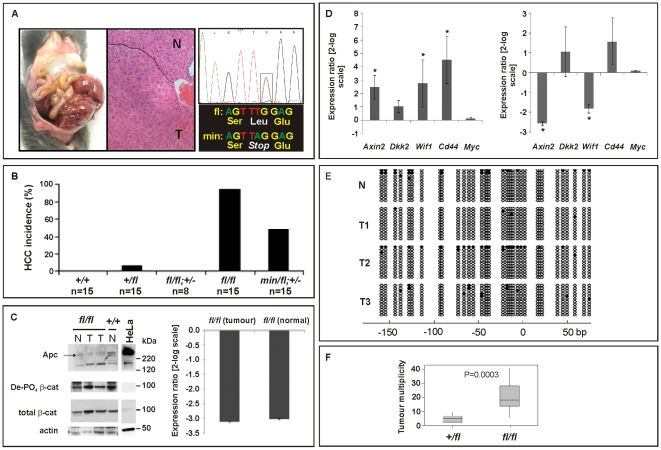
Liver phenotype in Apc mutant mice.(A) Hepatocellular carcinoma (HCC) of moribund Apcfl/fl and representative haematoxilin-eosin stained cross section with the dotted line indicating the boundary between normal (N) and tumoral (T) tissue. Representative allele-specific nucleotide sequence of DNA extracted from a liver tumor of a (min/fl; +/−) mouse demonstrating allelic balance between of the Apcmin and the floxed wt allele (boxed area). (B) Incidence of HCC in mice of the indicated genotypes. (C) Western blot and qPCR analysis of full-length Apc protein and Apc mRNA in normal (N) and tumoral (T) liver tissue of Apcfl/fl and Apc+/+ mice. Cell lysates of HeLa cells transfected with a plasmid encoding full-length wild-type Apc serves as an antibody specificity control. The abundance of de-phosphorylated, active (De-PO4) and total β-catenin protein in the same tissue extracts are shown with β-actin serving as a loading control. kDa, protein size marker in kilo Daltons. (D) Comparative qPCR analysis of representative Wnt target gene expression between normal and tumoral liver tissue collected from moribund Apcfl/fl mice (right panel). A comparable analysis was also performed on liver tissue from healthy 5mo old Apcfl/fl and wild-type mice (left panel). Mean ± SD with n≥3 mice per group. * P<0.05. (E) Bisulfite sequencing of the CpG island within the Axin2 promoter from adjacent normal (N) and tumor liver tissue (T1, T2, T3) from Apcfl/fl mice. Each vertical line refers to a CpG dinucleotide at the indicated position relative to the transcriptional start site. Following bisulfite-treatment, DNA was subcloned and sequenced. Horizontal lines represent individual sequences with open and full circles denoting unmethylated and methylated CpG residues, respectively. (F) Boxplot diagram comparing liver tumor multiplicity in +/fl mice (n = 9) and fl/fl mice (n = 12) 6 to 8 months after treatment with DEN. p = 0.0003 (Mann-Whitney). Genotypes are as follows: wild-type (+/+); Apc+/fl (+/fl); Apcfl/fl (fl/fl); Apcfl/fl;Ctnnb1+/− (fl/fl; +/−); Apcmin/fl;Ctnnb1+/− (min/fl; +/−). All mice were on a mixed 129Sv x C57BL/6 background.